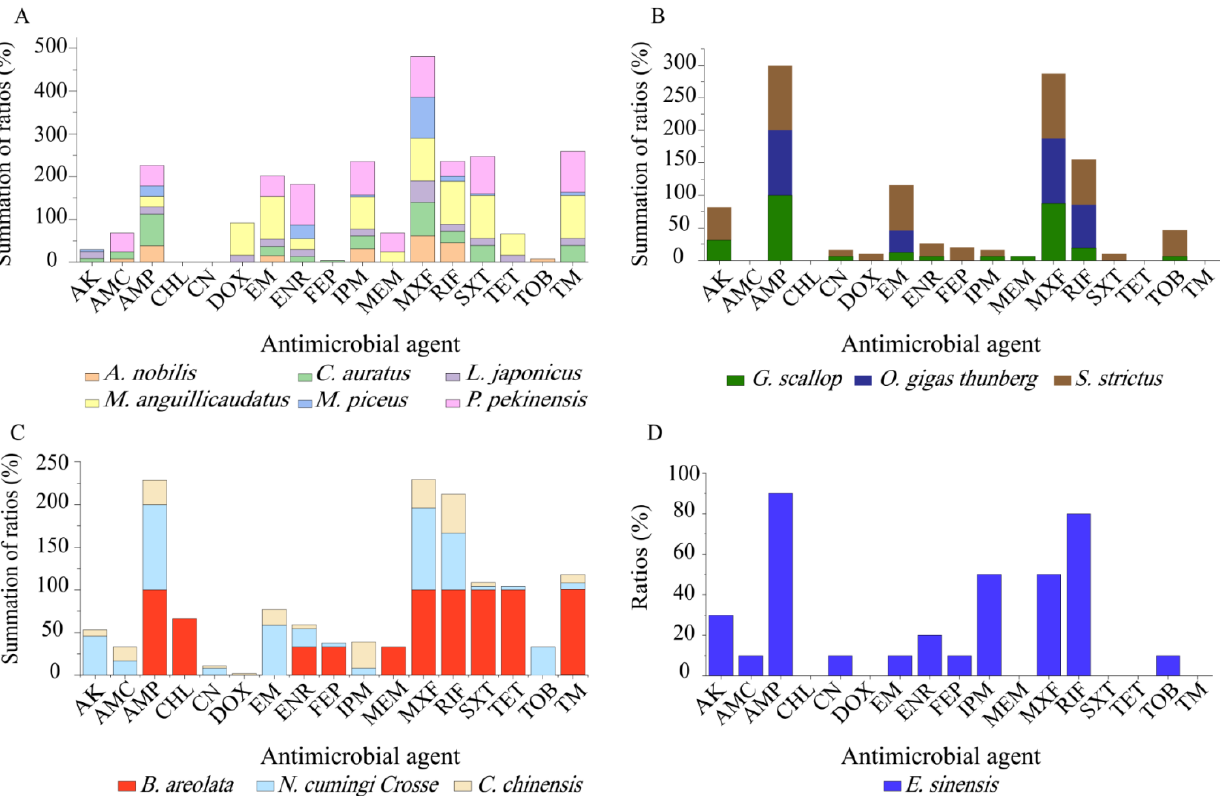
Figure 5. Antimicrobial resistance profiles of the V. cholerae isolates in the 13 species of aquatic food animals. ( A – D ): the species of fish, shellfish, snails, and crab, respectively.